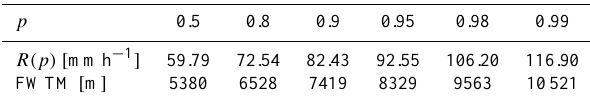
Table 1. Annual probability of non-exceedance p, associated rain- fall intensity R(p) as estimated with the fitted generalized Pareto distribution, and the assumed extent (FWTM, Full Width at Tenth of Maximum) of the synthetic rainstorm associated to the